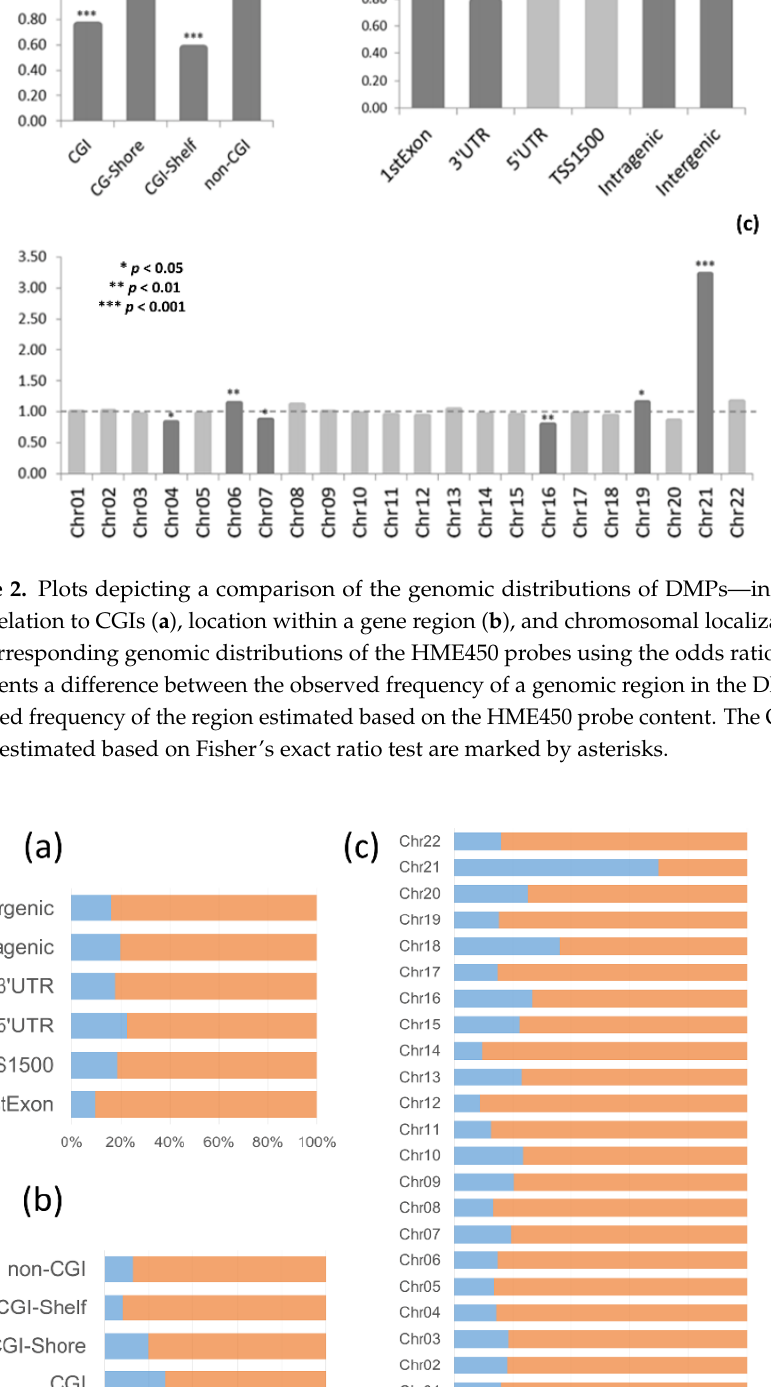
autosomes; most of the DMPs on chromosome 21 were hypomethylated—69.6% com- pared to 18.3% ± 6.4% of hypomethylated DMPs on the other autosomes (Figure 3c). Con- sidered separately, the percent distributions of hypermethylated and hypomethylated DMPs by genomic regions and chromosomes also indicate a distinctive methylation pro- file of chromosome 21, compared to the other autosomes (Figure 4). On chromosome 21, the hypomethylated CpGs in DS are remarkably predominant within CGIs (69.4% hypo- methylated DMPs vs. 24.4% ± 6.9% on other autosomes), especially those related to gene promoters: 5′UTRs (88.6% vs. 19.5% ± 8.6%) and regions upstream of the transcriptional start sites (TSS1500; 80.0% vs. 16.5% ± 8.7%).